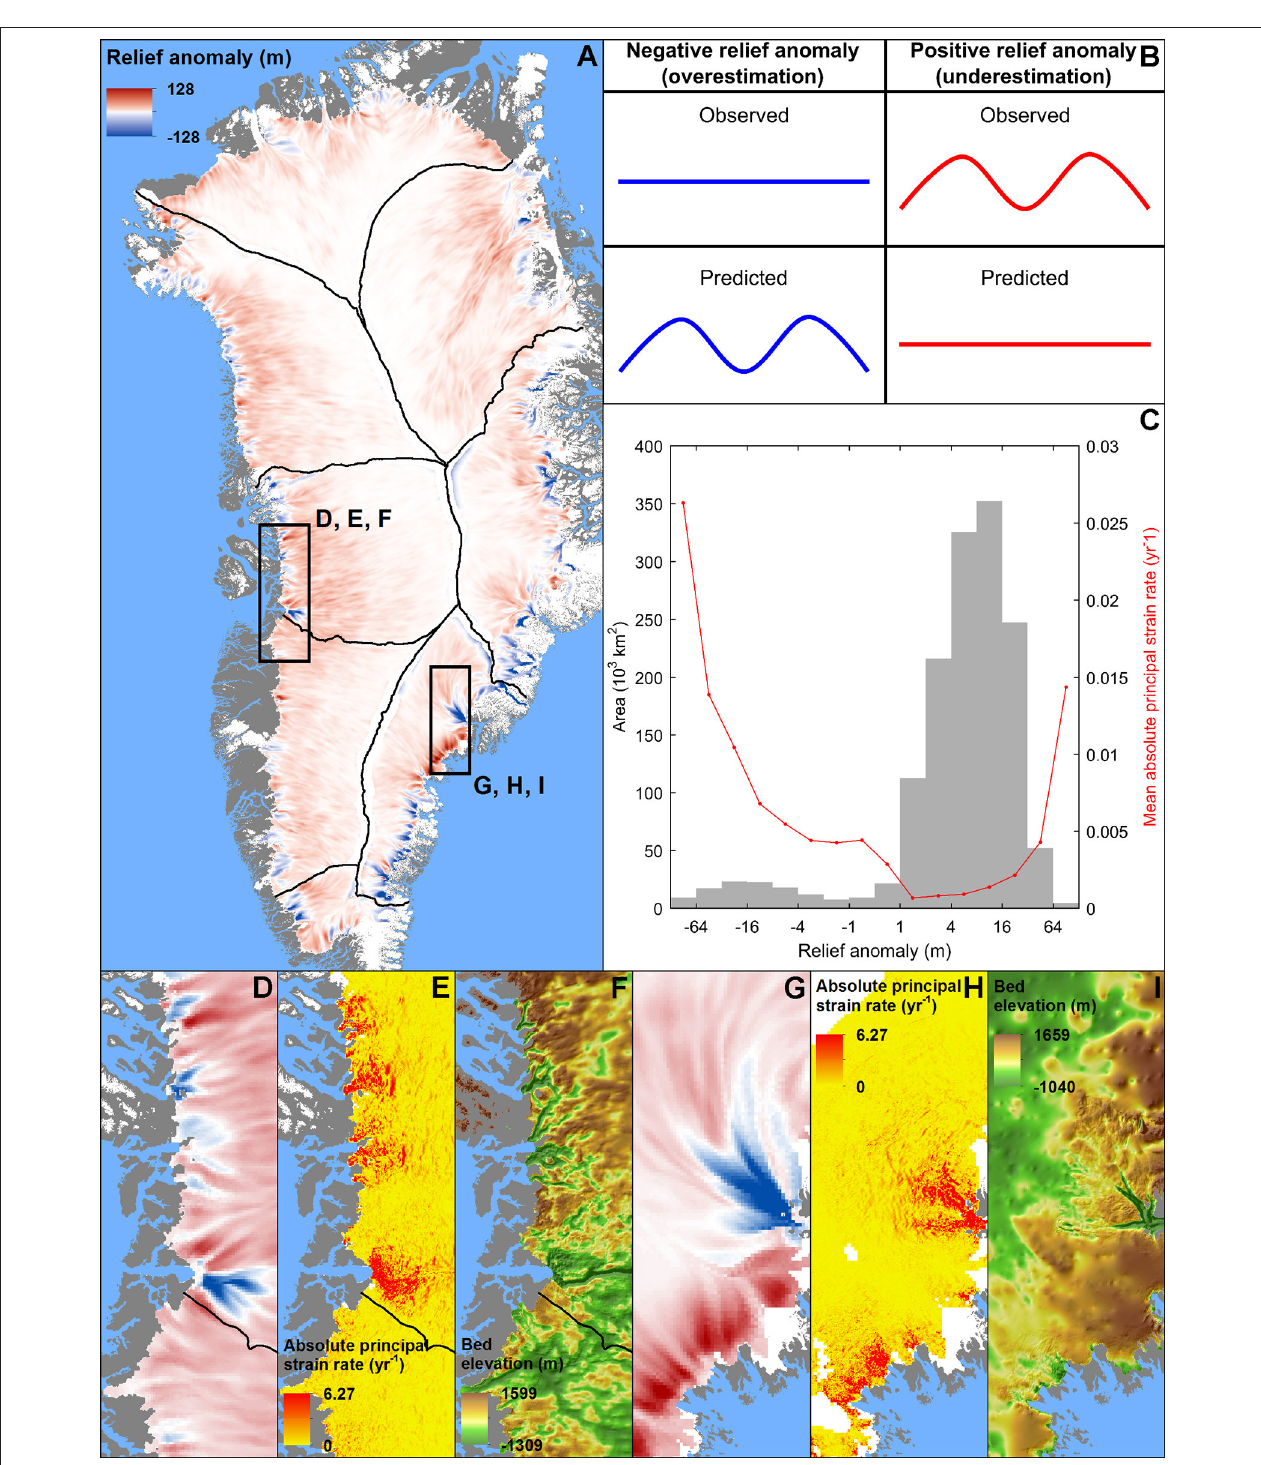
FIGURE 6 | (A) Map of surface relief anomaly across the GrIS. (B) Cartoon of surface topography explaining what the two types of relief anomaly. The anomaly is negative (blue) where the observed relief is less than predicted, and positive (red) where it is more than predicted. (C) Ice sheet-wide frequency distribution of relief anomalies and the corresponding means of the absolute principal strain rates, categories smaller than 4,500 km 2 have been removed and accordingly the color scale was capped on (A) . (D,G) Relief anomaly, (E,H) absolute principal strain rate (F,I) , and bed topography in the two regions outlined by the boxes in (A) .